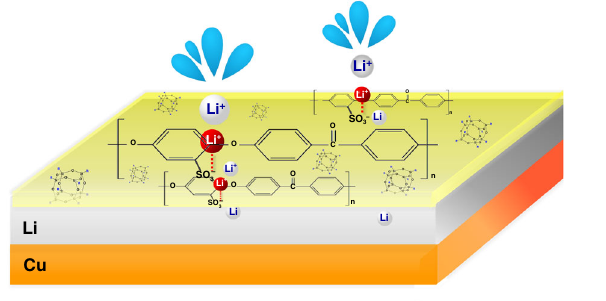
Fig. 1 Ionomer interphase for effective Li metal anodes. Schematic showing Li plating and stripping on the SPEEK-Li/POSS-coated Cu: solvated Li ions undergo desolvation and diffusing across the cation-selective membrane to form a uniform and dense Li metal layer, which is subsequently removed, in between the membrane and Cu surface with a high CE and excellent long-term cycling stability.